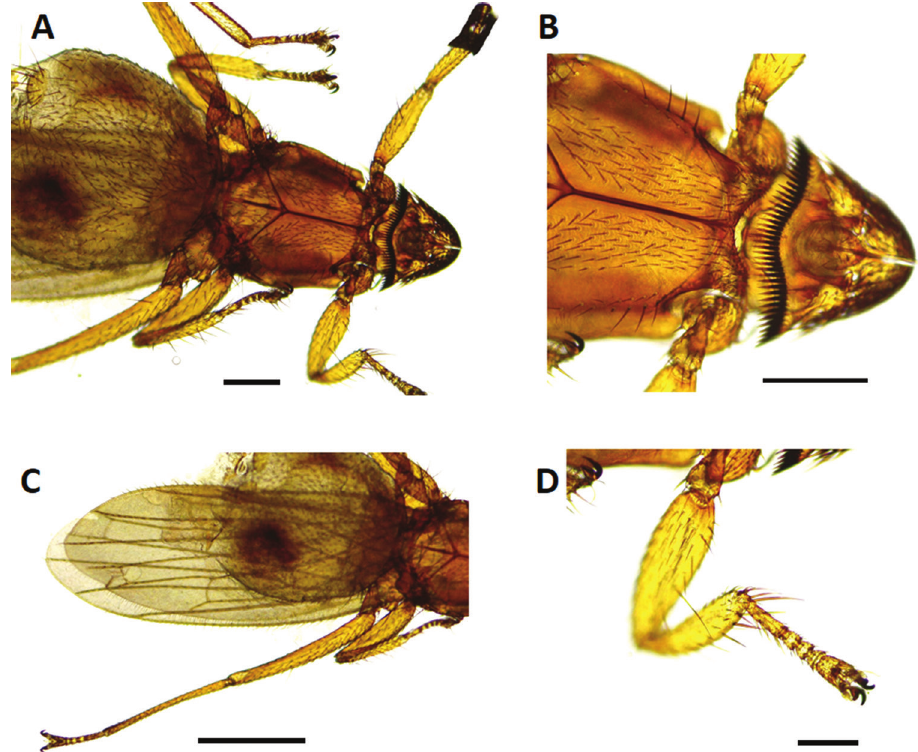
Figure 1. A ventral view of Anastrebla modestini , 40× magnification B detail of head, 100× C detail of wing and leg, 100× D detail of femur and setae, 100×. Leica DM500 optical microscope. Scale bars: 0.5 mm ( A–D